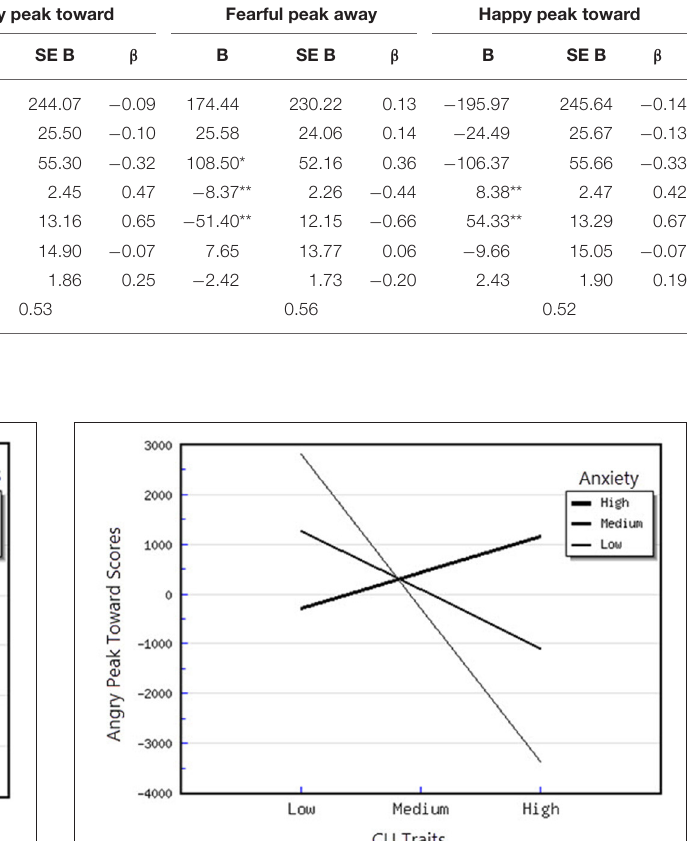
TABLE 3 | Hierarchical regression analysis for variables predicting TL-BS parameters. Variable Angry peak away Angry peak toward Fearful peak away Happy peak toward